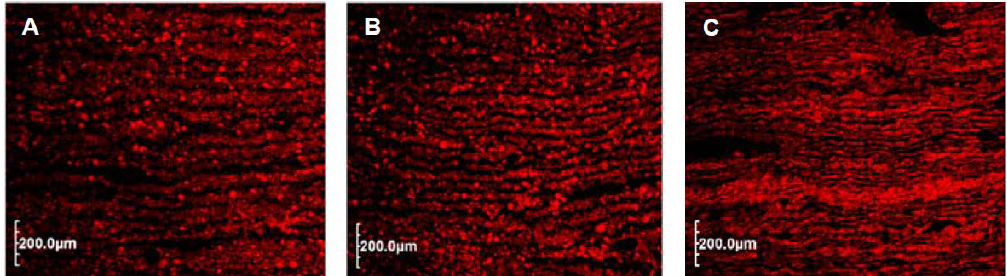
Figure 4. Confocal Laser Scanning Microscope representations of cross sections of laminated puff pastry dough (unbaked); protein network and starch granules (red) of the dough layers and intermediate fat layers (black). ( A ) 40% fat-reduced puff pastry (48 layers, 2.25 mm) ( B ) improved puff pastry control (81 layers, 2.50 mm) ( C ) puff pastry control (144 layers 2.50 mm).